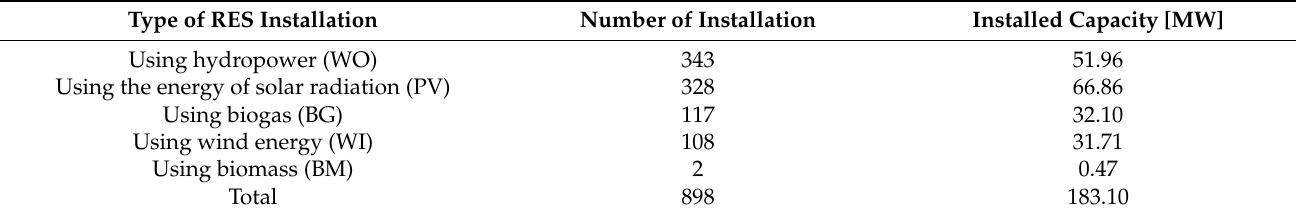
Table 10. RES installation entered in the register of energy producers in a small installation, by source type (as at the end of 2020).